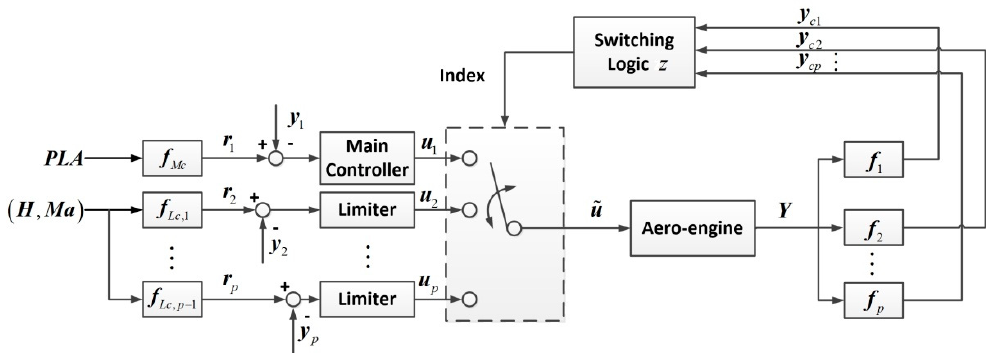
Figure 2. Multi-loop switching control strategy for aero-engines.